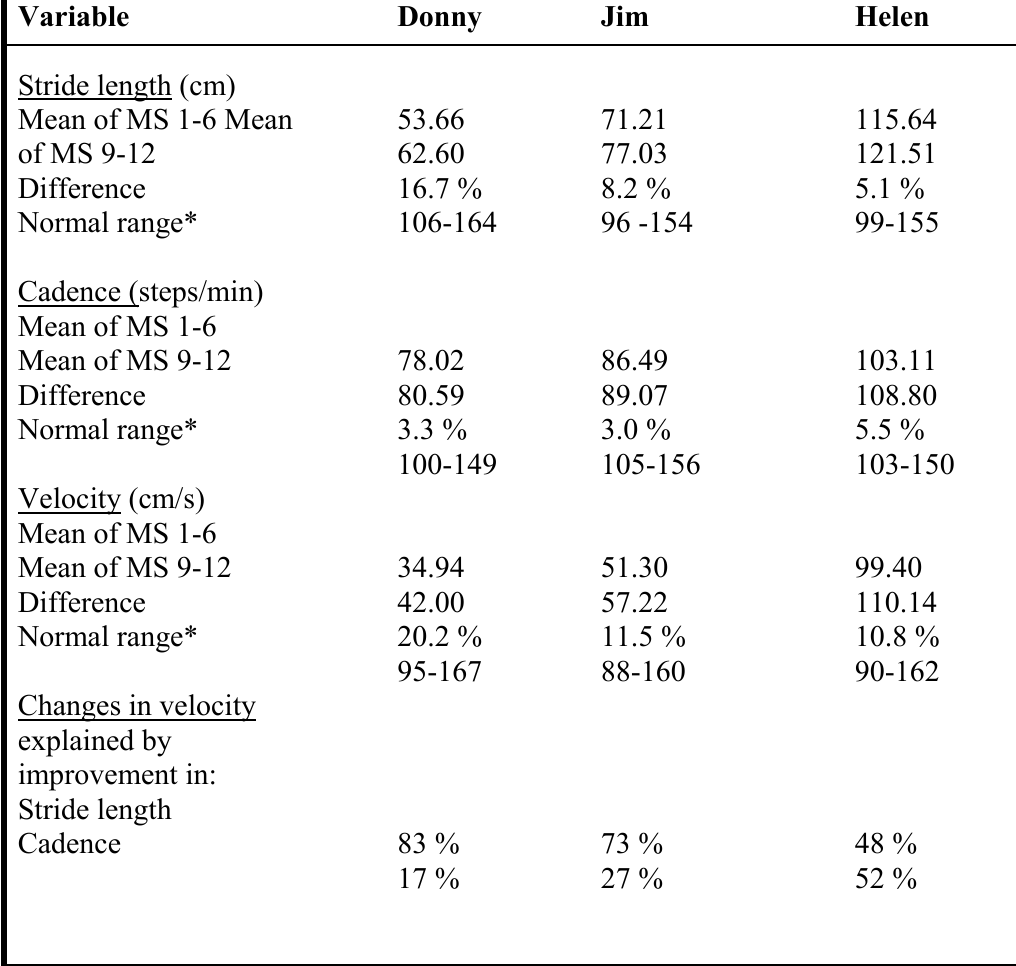
Table 2. Mean values of gait parameters before (MS 1-6) and after (MS 9-12)